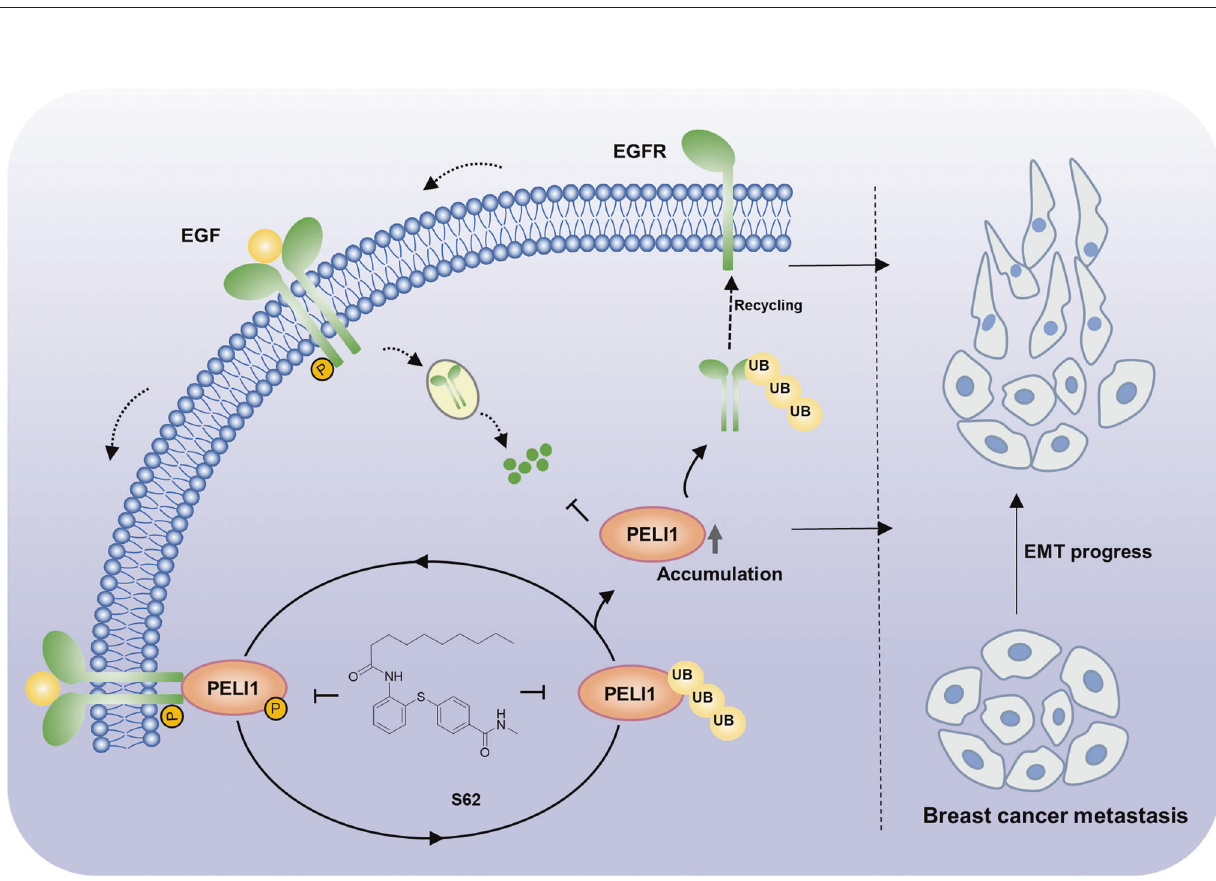
Fig. 6 The compound S62 interrupted the interaction between PELI1 and EGFR to suppress breast cancer metastasis. A Chemical structure of S62. B HEK293T/17 cells with overexpression of PELI1 and EGFR were treated with or without S62 (5 or 10 μ M) for 24 h. Co-IP assay was subsequently performed to detect the interaction between PELI1 and EGFR. C Western blotting analysis of EGFR and PELI1 in MBA-MB- 231 cells with the treatment of S62 for 24 h. D Flow cytometric analysis of the membrane EGFR in MDA-MB-231 cells treated with or without S62 for 24 h ( N = 3). E Western blotting analysis of EGFR, PELI1 and phosphorylation of EGFR with or without the treatment of S62 (10 μ M) upon EGF stimulation (100 ng/ml). F Western blotting analysis of the tyrosine and threonine phosphorylation of PELI1 immunoprecipitated from MDA-MB-231 cells. The cells were treated as in E . G Western blotting analysis of the K63-mediated polyubiquitination of EGFR immunoprecipitated from HEK293T/17 cells with the treatment of S62 (10 μ M). H Quantitative analysis of the migration of MDA-MB-231 cells with the treatment of S62 ( N = 3). I Effect of S62 on the invasion of MDA-MB-231 cells. The representative images of invasive cells were shown (scale bar, 100 μ m). J Quantitative analysis of the invasion of MDA-MB-231 cells in I ( N = 3). K Western blotting analysis of E-cadherin and SNAIL in MDA-MB-231 cells with the treatment of S62. L The representative images of lung metastasis of breast cancer cells in NYG mice with S62 treatment. MDA-MB-231 transfected with lentivirus that stably expressed luciferase (2 × 10 5 /mouse) were injected into NYG mice via the tail vein. The mice were treated with CMC-Na (0.5%) or S62 (10 or 50 mg/kg) every day for 2 weeks, and then were detected using the bioluminescence imaging. * P < 0.05, *** P < 0.001. All P values were determined by unpaired two-tailed Student ’ s t test.